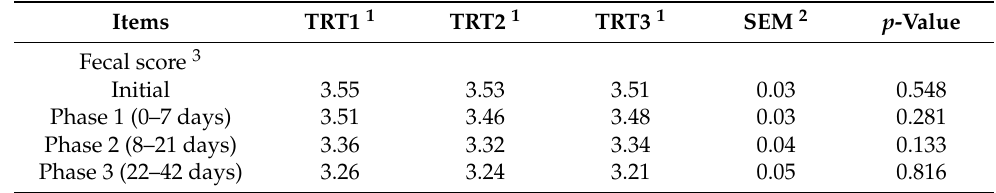
Table 6. Effect of blood plasma and yeast supplementation on the fecal score of weaning pigs 1